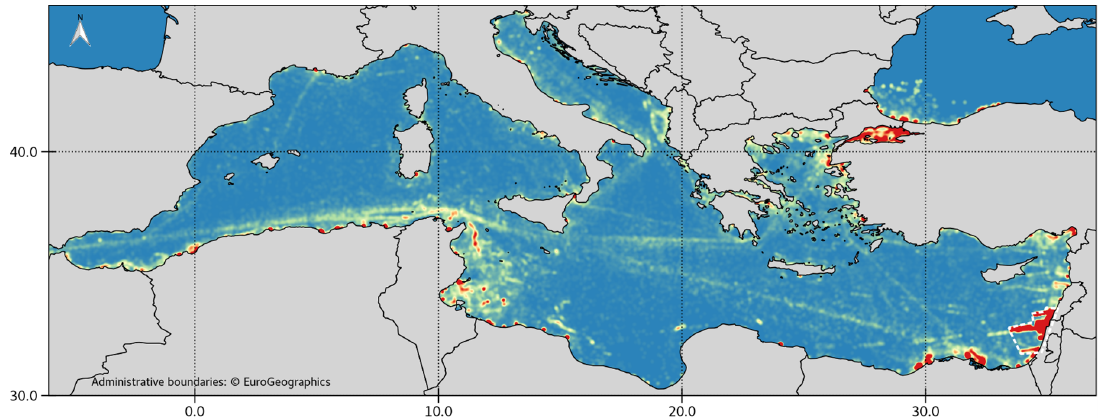
Figure 10 . Density map of uncorrelated, non-recurrent ship detections (164,776). Area off Israel with high concentration of RFI-related detections is indicated as a white polygon.